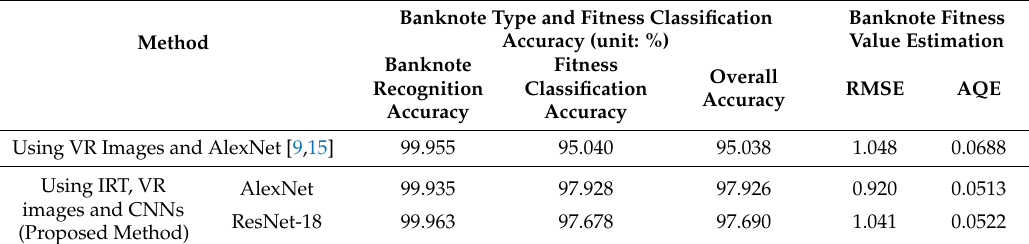
Table 9. Comparison of banknote type and fitness classification and banknote fitness value estimation results by our proposed method to that of previous method. “RMSE” denotes root-mean-squared error, “AQE” denotes average quantization